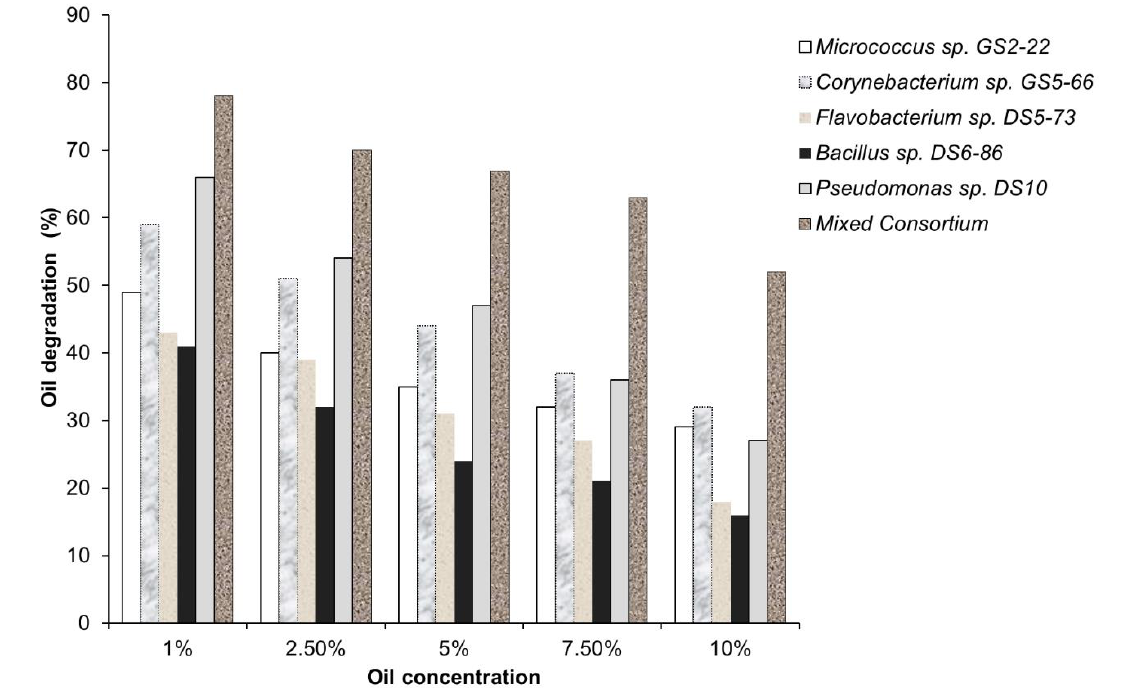
Figure 13. Biodegradation of BH crude oil by pure bacterial cultures and mixed bacterial consortium in different oil concentrations (%) after 20 days of incubation. Modified from Rahman, et al. [124].